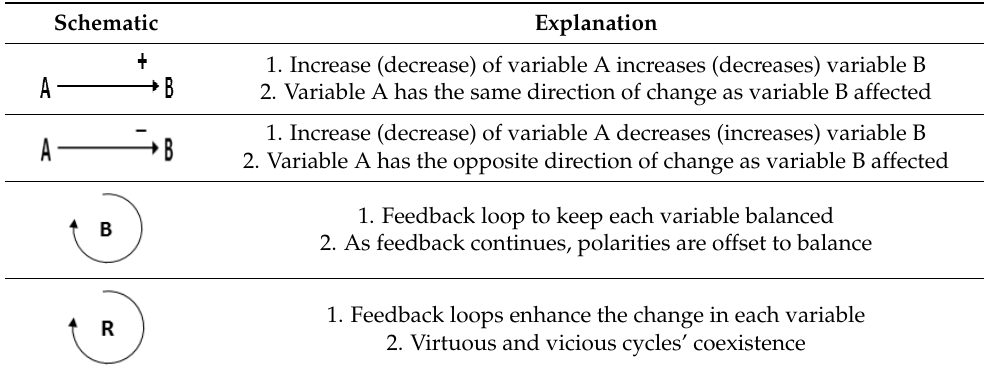
Table 6. Primary schematic diagram of causality map.